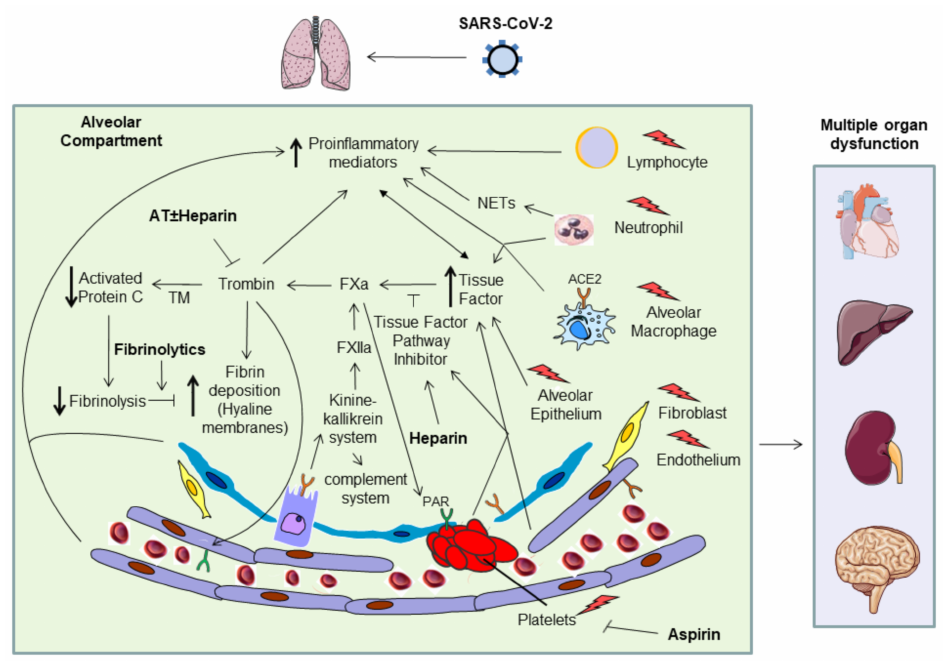
Figure 1. Coagulation and inflammatory pathway active by SARS